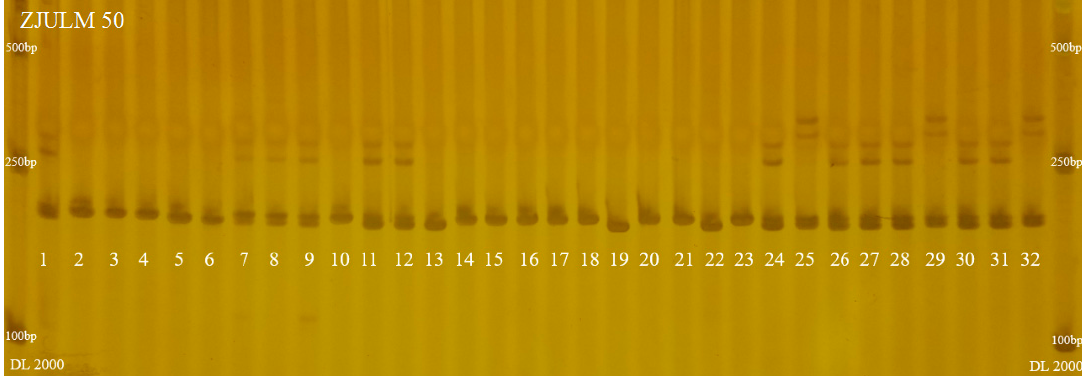
Figure 7. Results of PCR products obtained with the SSR marker ZJULM 50 on 6% denaturing polyacrylamide gel at 60 mA constant current (Nos. 1–32, 32 accessions, detailed explanation can be seen in Table 6; DNA Marker: DL2000).